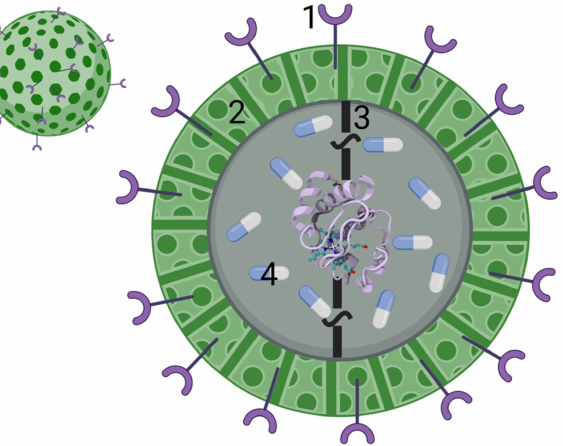
Figure 12. Smart DDS for delivery of Cyt c into cancer cells. Typical scaffolds consist of one or